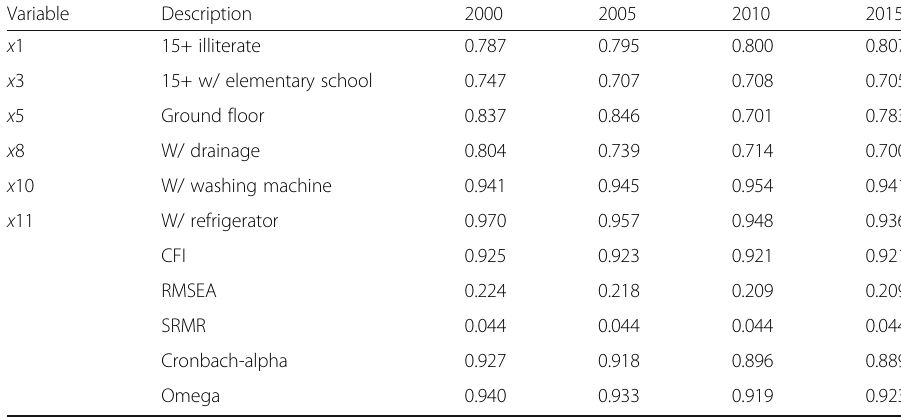
Table 4 Factor loadings corresponding to the first-order CFA Variable Description